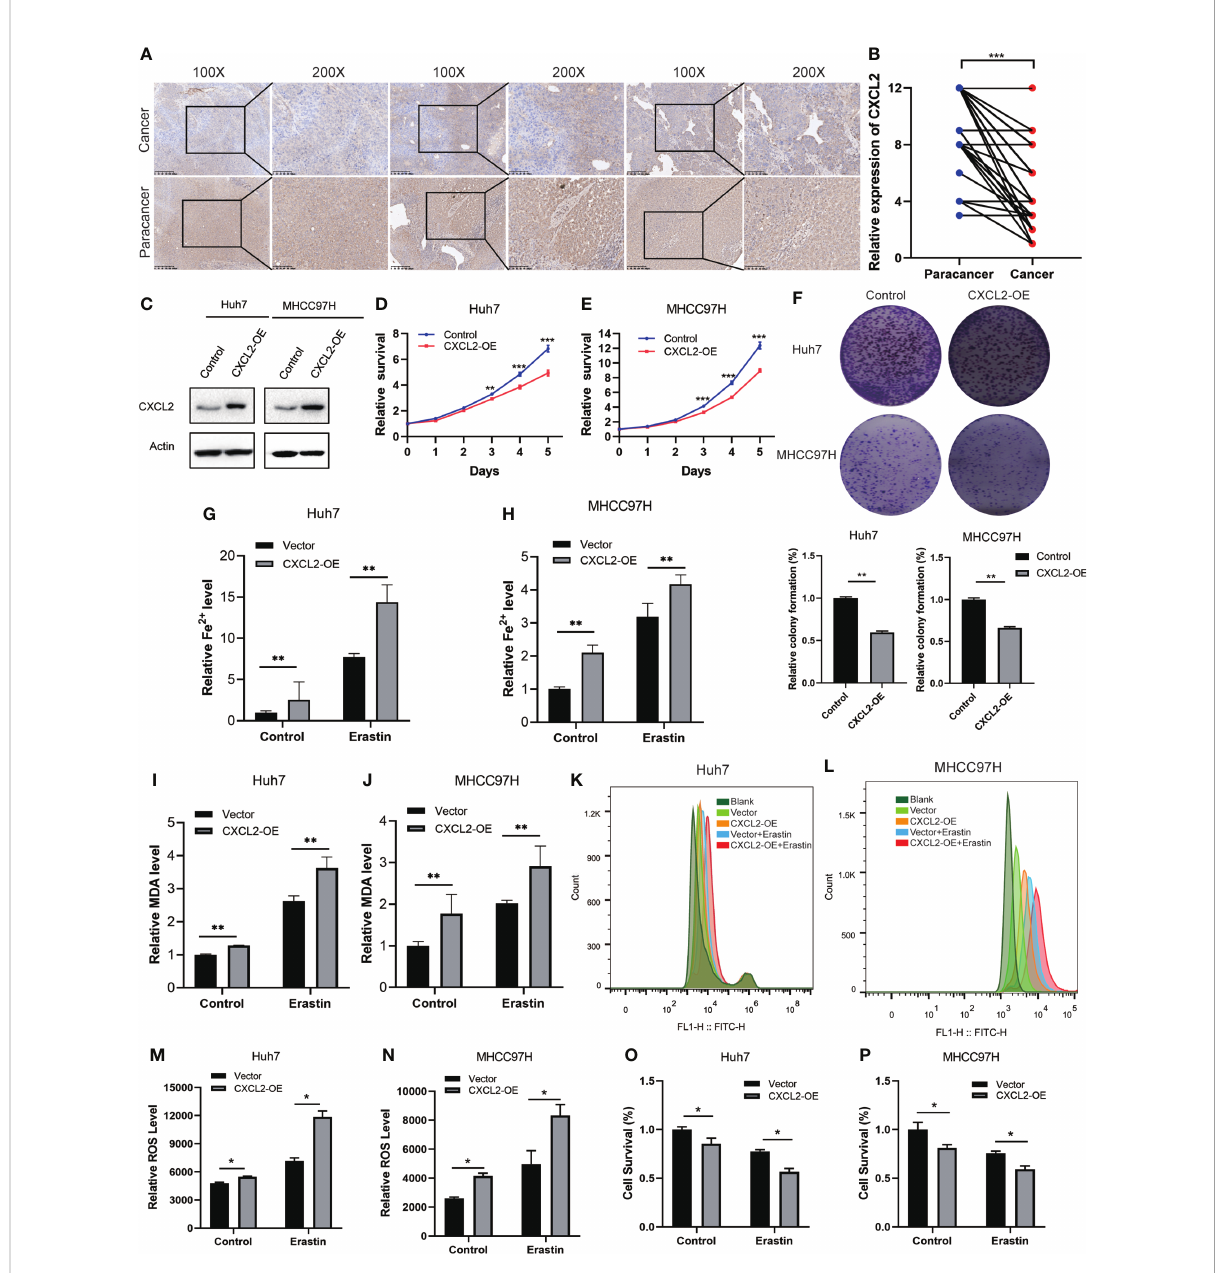
FIGURE 4 CXCL2 overexpression inhibited cell proliferation. (A) IHC images of CXCL2 in paired HCC and paracancerous tissues. (B) The histologic score of CXCL2 expression in paired HCC and paracancerous tissues. (C) Western blotting validated the overexpression of CXCL2 in two HCC cell lines, Huh7 and MHCC97H. (D-F) CCK-8 and colony formation assay revealed that CXCL2 overexpression inhibited cell growth and proliferation. (G-J) Fe 2+ and MDA levels were detected in Huh7 and MHCC97H cells transfected with CXCL2 overexpression plasmids. (K-N) Intracellular ROS levels were elevated in Huh7 and MHCC97H cells with CXCL2 overexpression. (O, P) CCK-8 assay suggested that the combination of CXCL2 overexpression and erastin signi fi cantly inhibited cell survival in Huh7 and MHCC97H cells. * represents P < 0.05, ** represents P < 0.01, *** represents P <